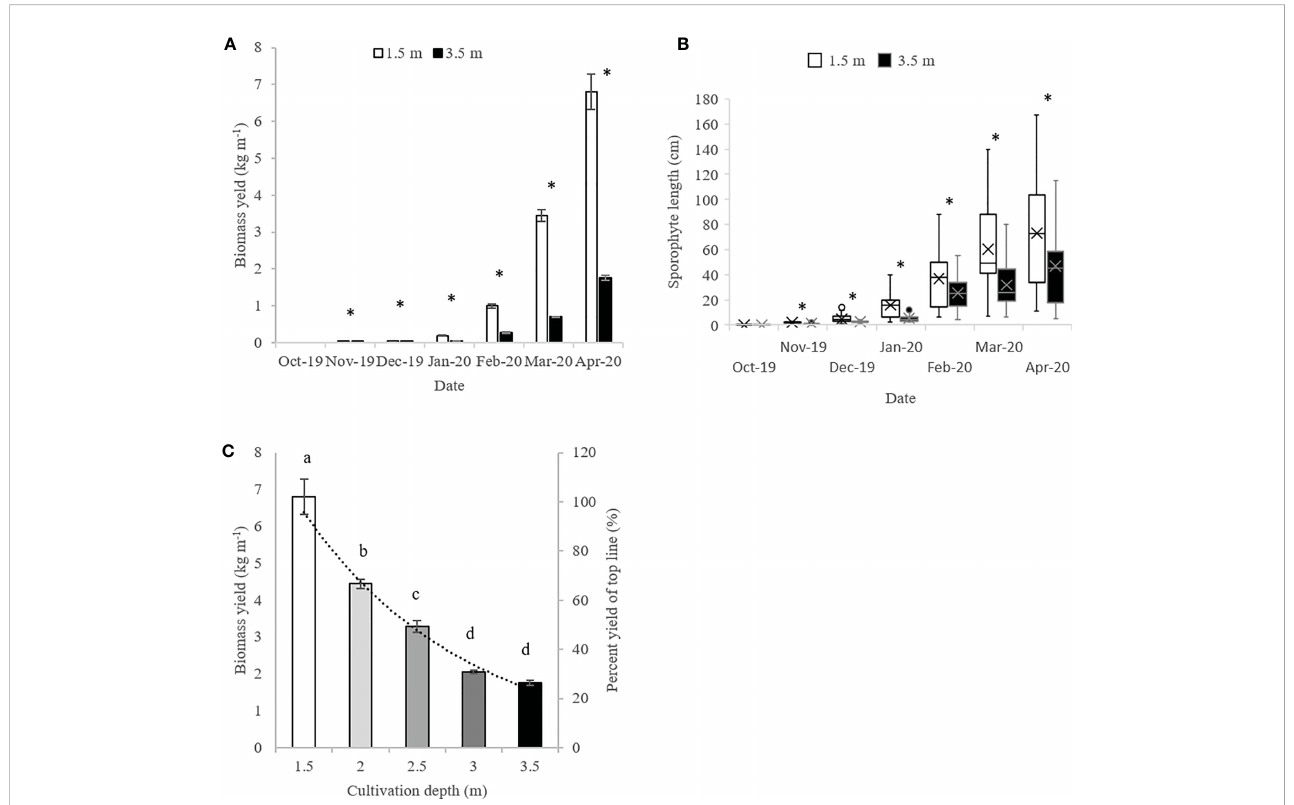
FIGURE 6 (A) Biomass yields and (B) sporophyte length (cm) of S. latissima sporophytes at 1.5 and 3.5 m cultivation depth in the horizontal 5-line system from October 2020 - April 2020. (C) Biomass yields at 1.5-3.5 m depth upon harvest in April in the horizontal 5-line cultivation system. *and letters mark signi fi cant differences between depths. In panel A and C, data are shown as average ± SE, n = 3. In panel B, quartiles are calculated including the median, and the median is marked with a line, the average with a cross and the max/min with whiskers in top/bottom of each box (n =